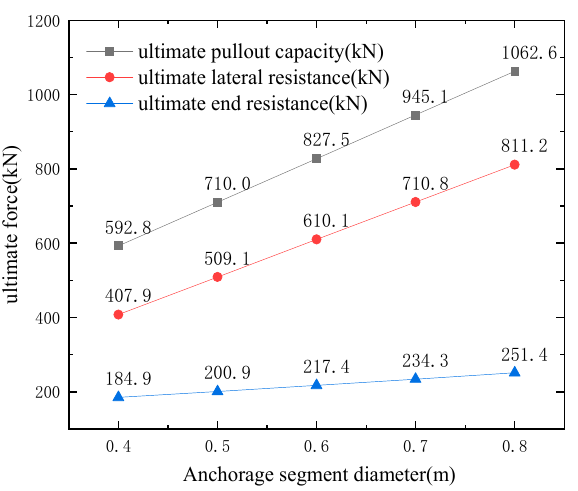
Figure 16. The ultimate force variation curves according to changes in the anchorage segment di-